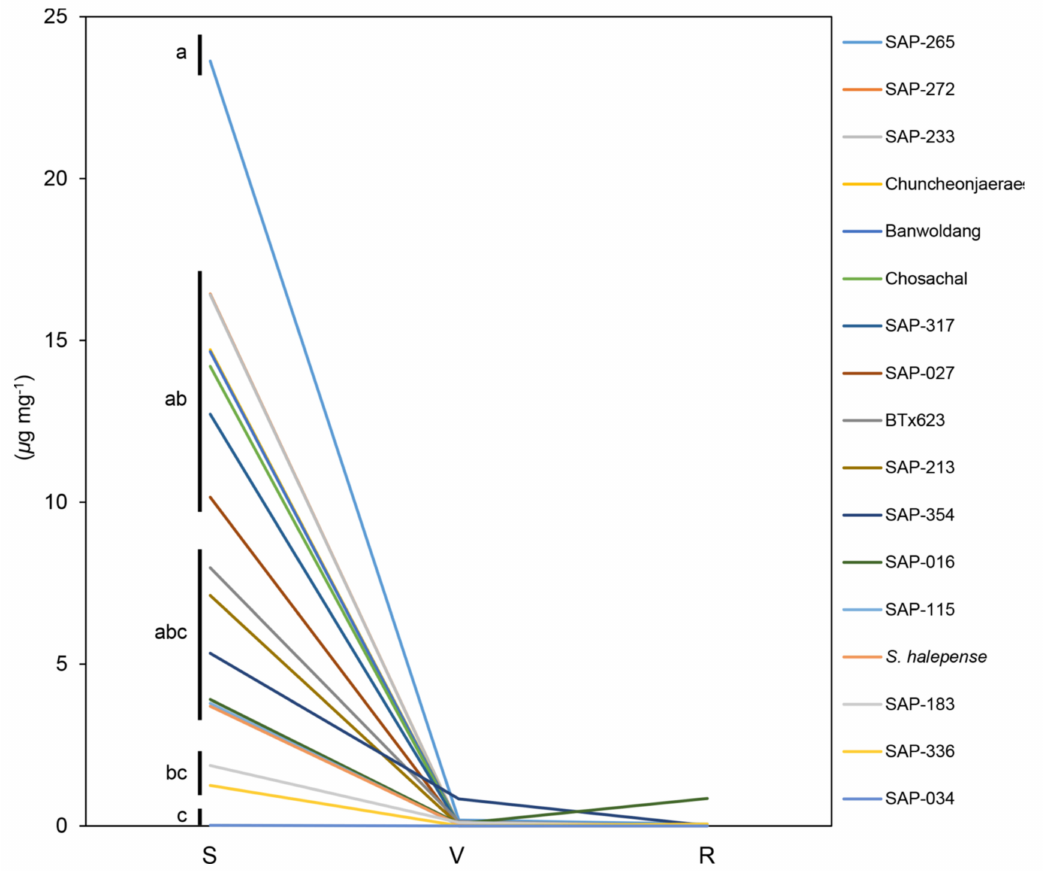
Figure 3. Grouping analysis of pHB contents by di ff erent developmental stages. A separate graph showing the pHB contents for each accession is given in the Figure S3. Y -axis, amount of pHB ( µ g mg − 1 ). X -axis, developmental stage. S, seedling stage (Z15 / 20); V, vegetative stage (Z19 / 47); R, ripening stage (Z19 / 87). Lower-case letters indicate homogeneous subsets for pHB contents only at seedling stage among the accessions ( p = 0.05). n = 3 or